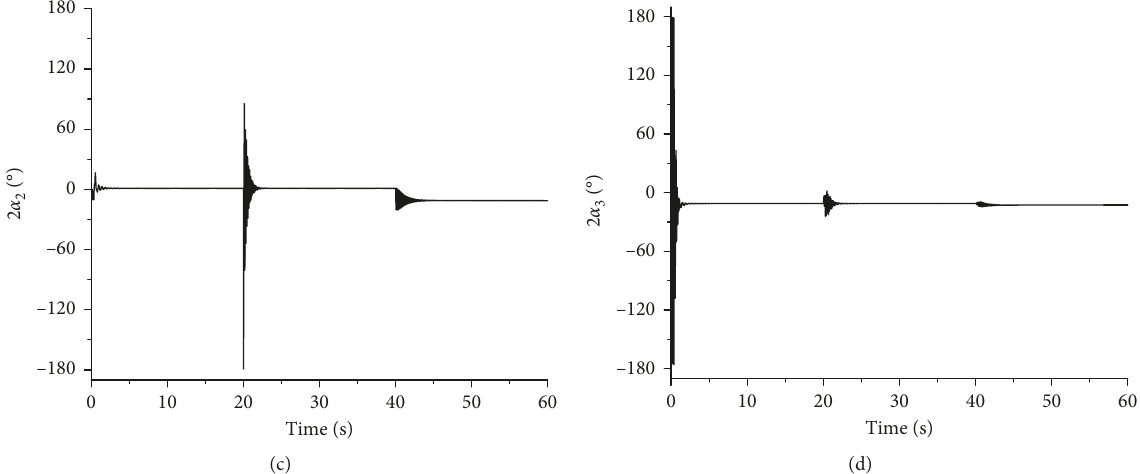
, η . 5. (a) Rotational velocities of the four motors; (b) phase difference 1 (cid:31) η 2 (cid:31) η 3 (cid:31) 1 4 (cid:31) 0